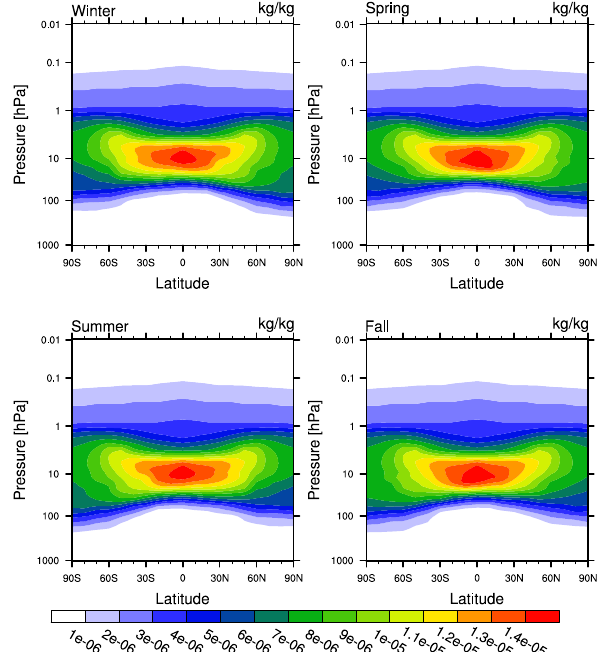
Figure 2. Ozone profile data sets available in GFDL.